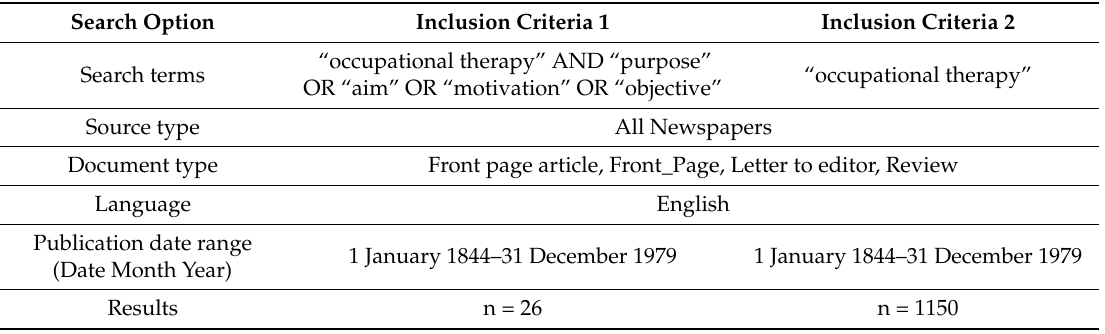
Table 2. PGM Search Strategy for identifying articles for qualitative (Inclusion Criteria 1) and quantitative data analysis (Inclusion Criteria